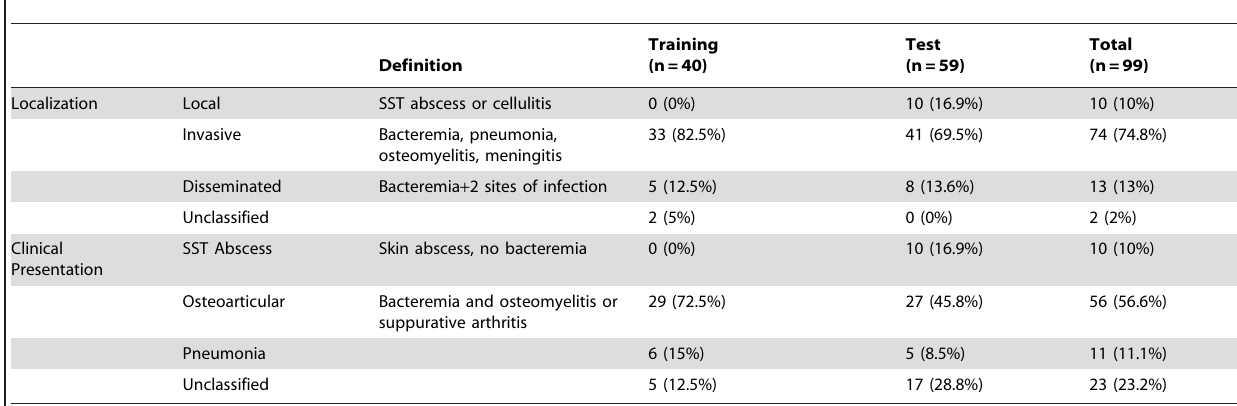
Table 2. Infection localization and clinical presentation distribution for training and test